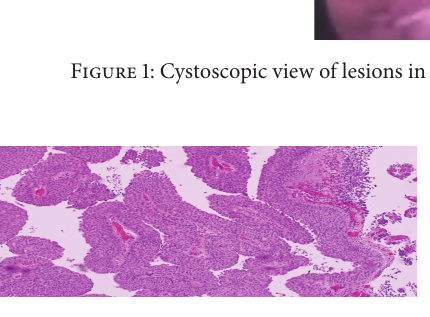
Figure2:Biopsyfromthetumoralareasoftheneobladder:papillary tumoural growth with low grade nuclear features (H&E × 200).